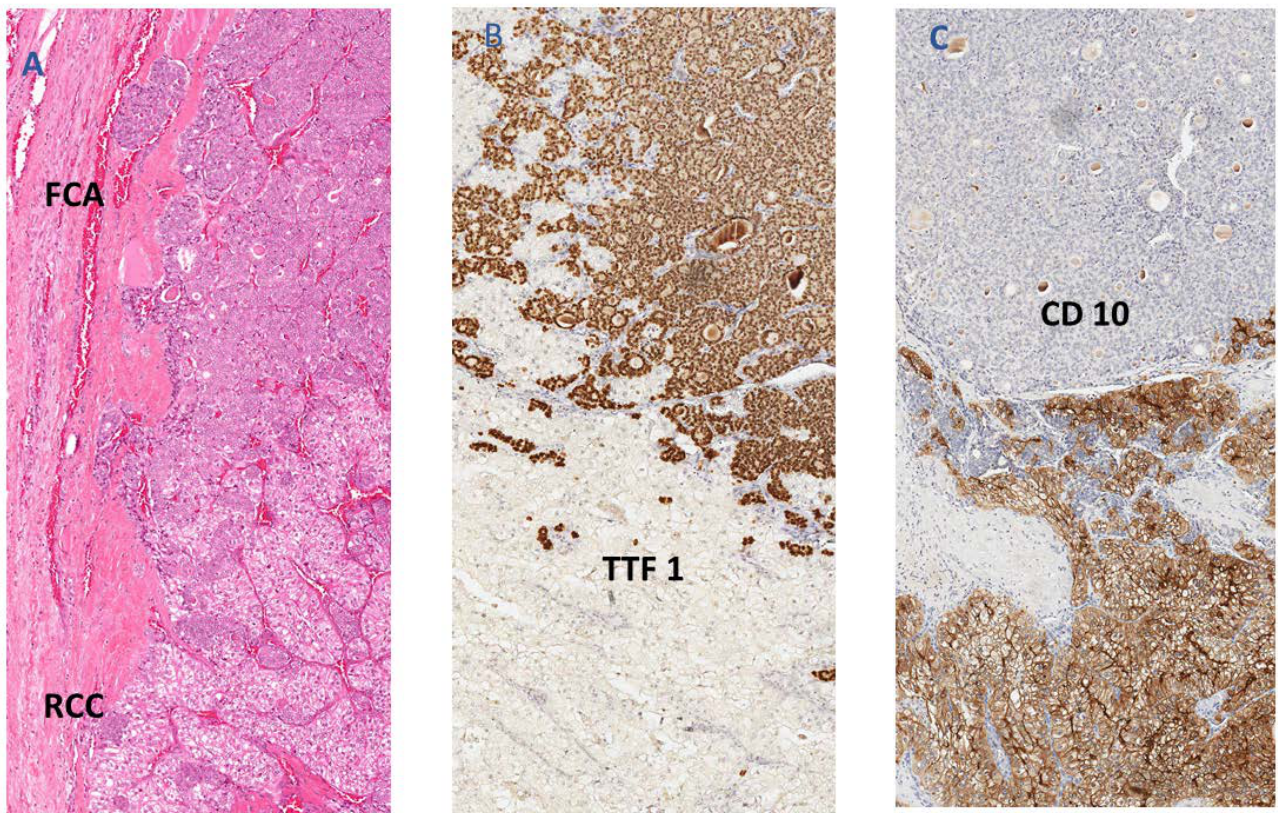
Figure 1. ( A ) Histology of a collision tumour in thyroid with primary follicular carcinoma (FCA) and metastatic renal cell carcinoma (RCC); ( B ) TTF-1 immunohistochemical stain is positive in the follicular cell carcinoma component; ( C ) CD10 immunohistochemical stain is positive in the renal cell carcinoma component.